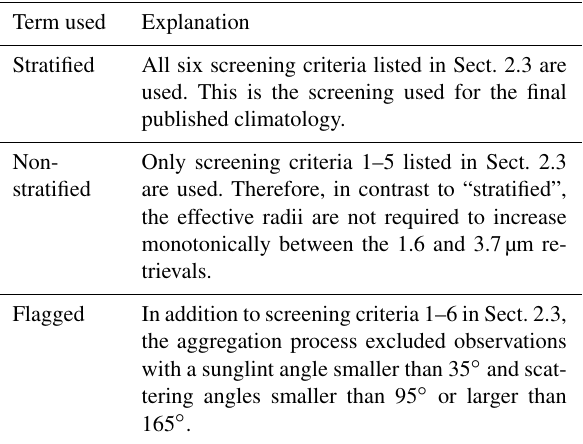
Table 1. Terminology used to differentiate various screening tests performed on the Level-2